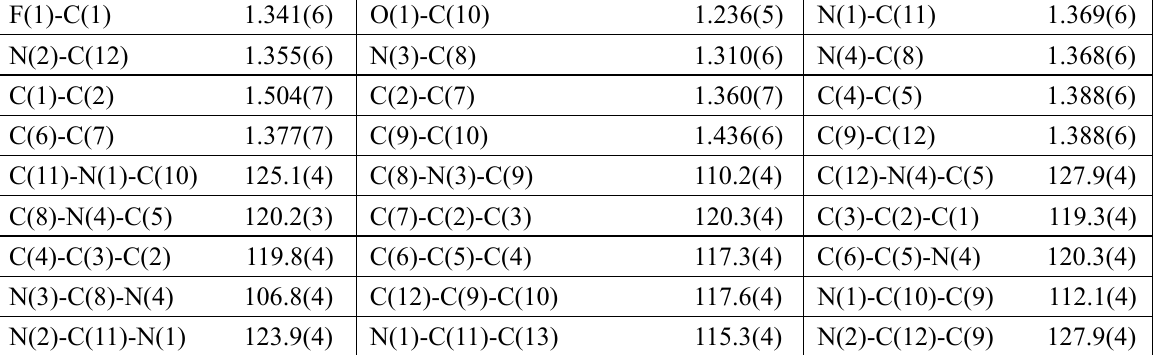
Table 3. Selected bond distances (Å) and angles (°) for compound 2c